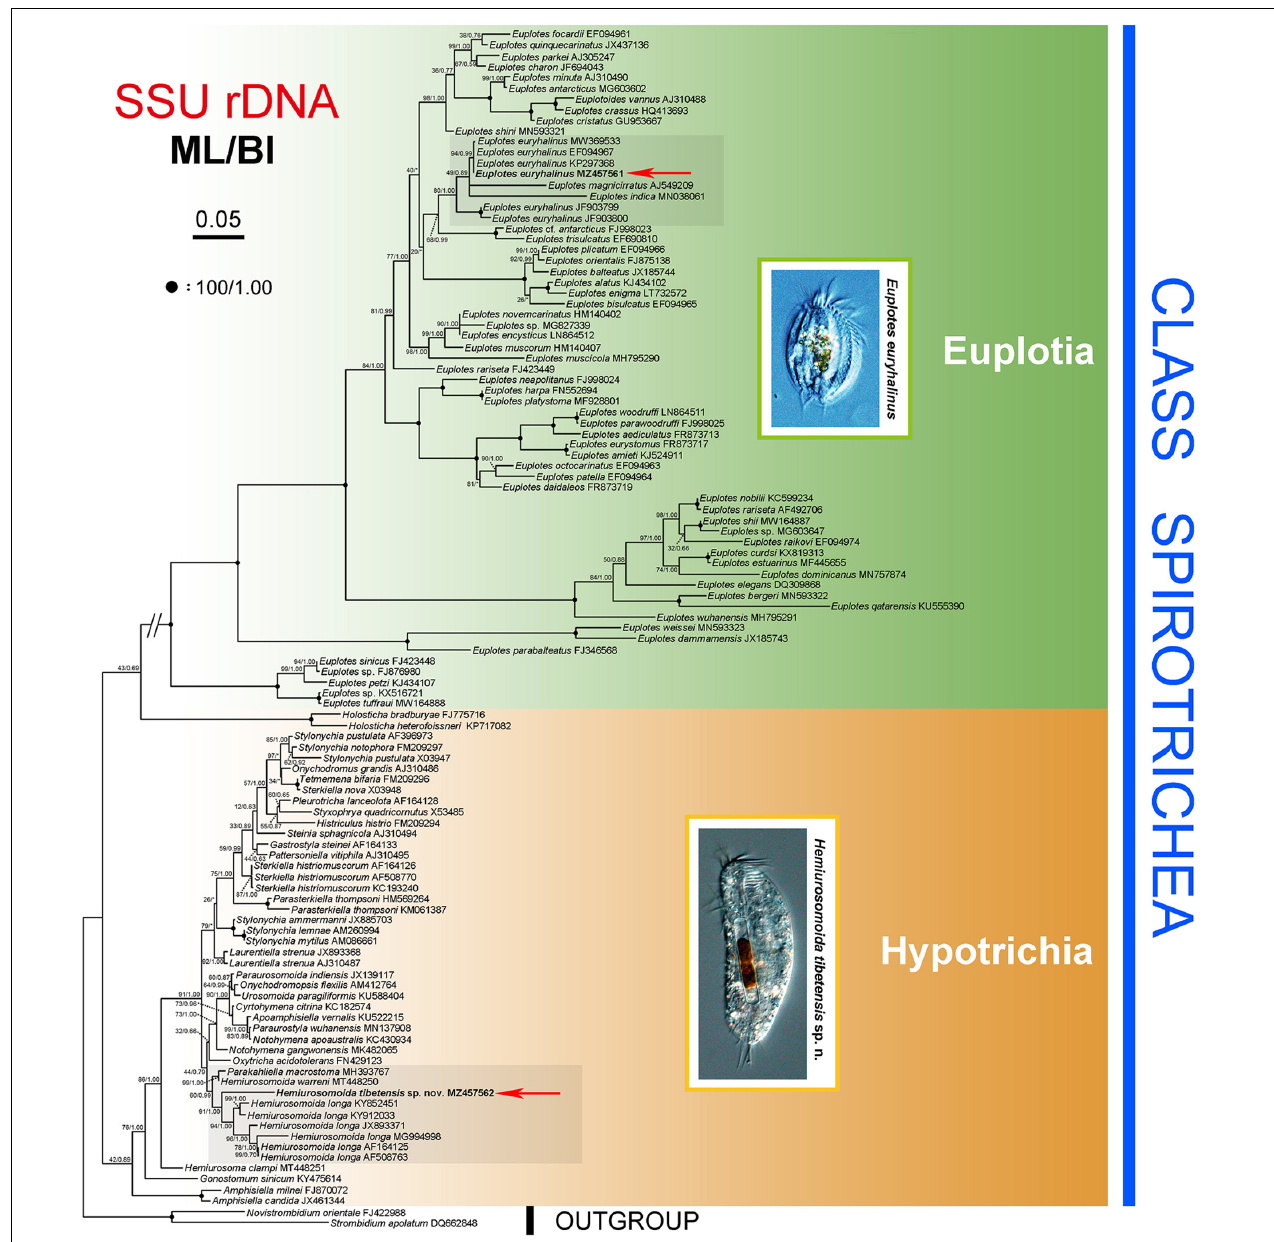
FIGURE 5 | Phylogenetic tree inferred from SSU rRNA gene sequences, revealing the phylogenetic position of Hemiurosomoida tibetensis sp. nov. and Euplotes euryhalinus (in bold). Numbers near nodes denote maximum likelihood (ML) bootstrap values and Bayesian inference (BI) posterior probabilities, respectively. The scale bar corresponds to five expected substitutions per 100